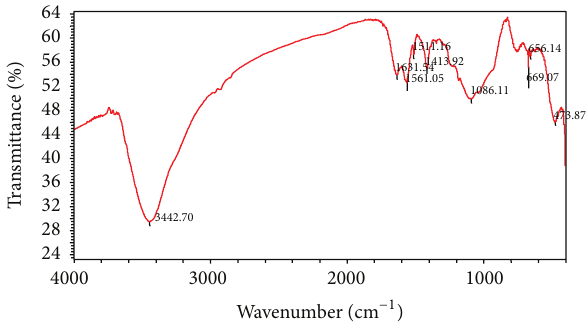
Figure 11: FTIR spectra of BO surface